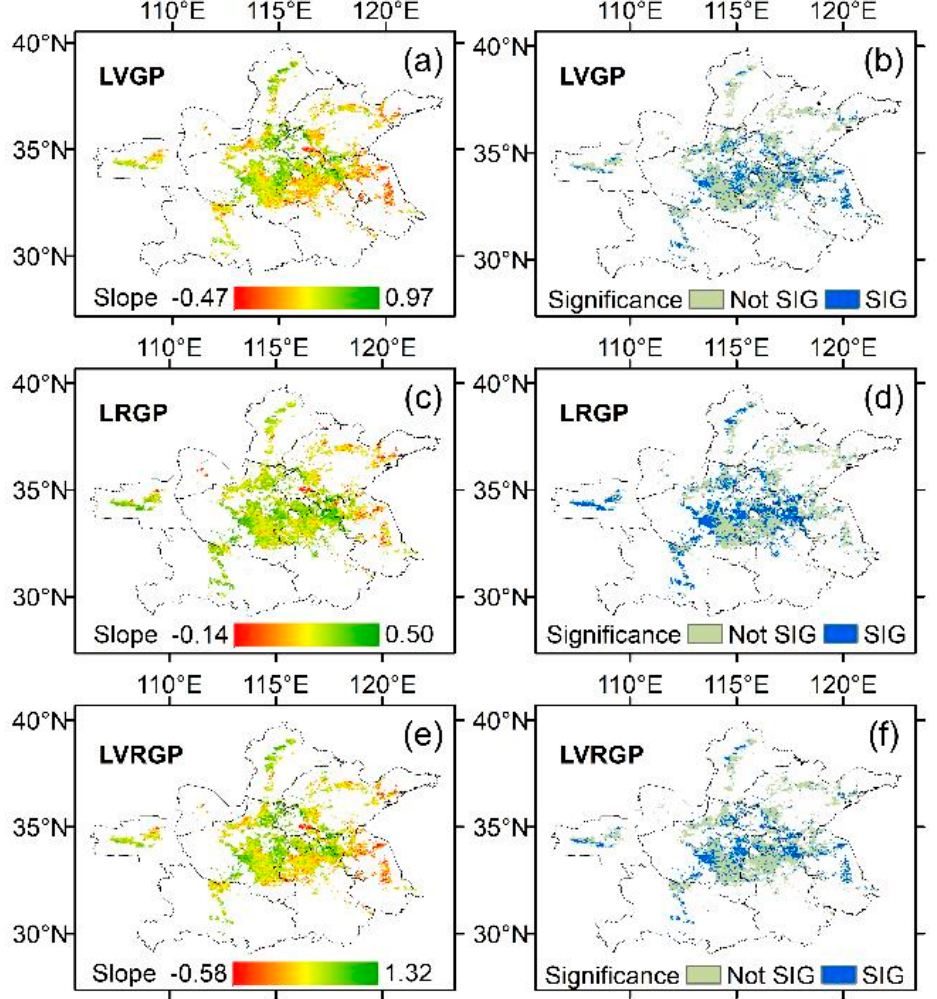
Figure 8. Trends of the growth period length (first column) calculated from 1981–1982 to 2015–2016 and its statistical significance (second column). The red color represents a shortened or decreasing trend, while the green color represents an extended or increasing trend. Negative slopes represent shortened trends, while positive slopes represent extended trends. Wheat pixels with statistically significant trends (P < 0.05) are indicated in blue, and pixels without statistical significance are indi ‐ cated in gray (P > 0.05). ( a , b ) represents trend and statistical significance for LVGP, ( c , d ) represents trend and statistical significance for LRGP, and ( e , f ) represents trend and statistical significance for LVRGP, respectively. Table 3. Proportion of shortened and extended lengths for different growth periods.